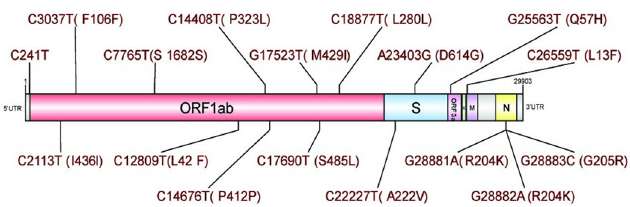
Fig 5. Localization of the mutations on the SARS-CoV-2 genome. The mutations were detected among the genome sequences of 13 patients who applied to our department. The figure was drawn by DOG v2 [47]. Different regions of the viral genome are represented by different colors. Open Reading Frame (ORF), envelope (E), spike (S), membrane (M), and nucleocapsid (N). Amino acid changes are shown in brackets.